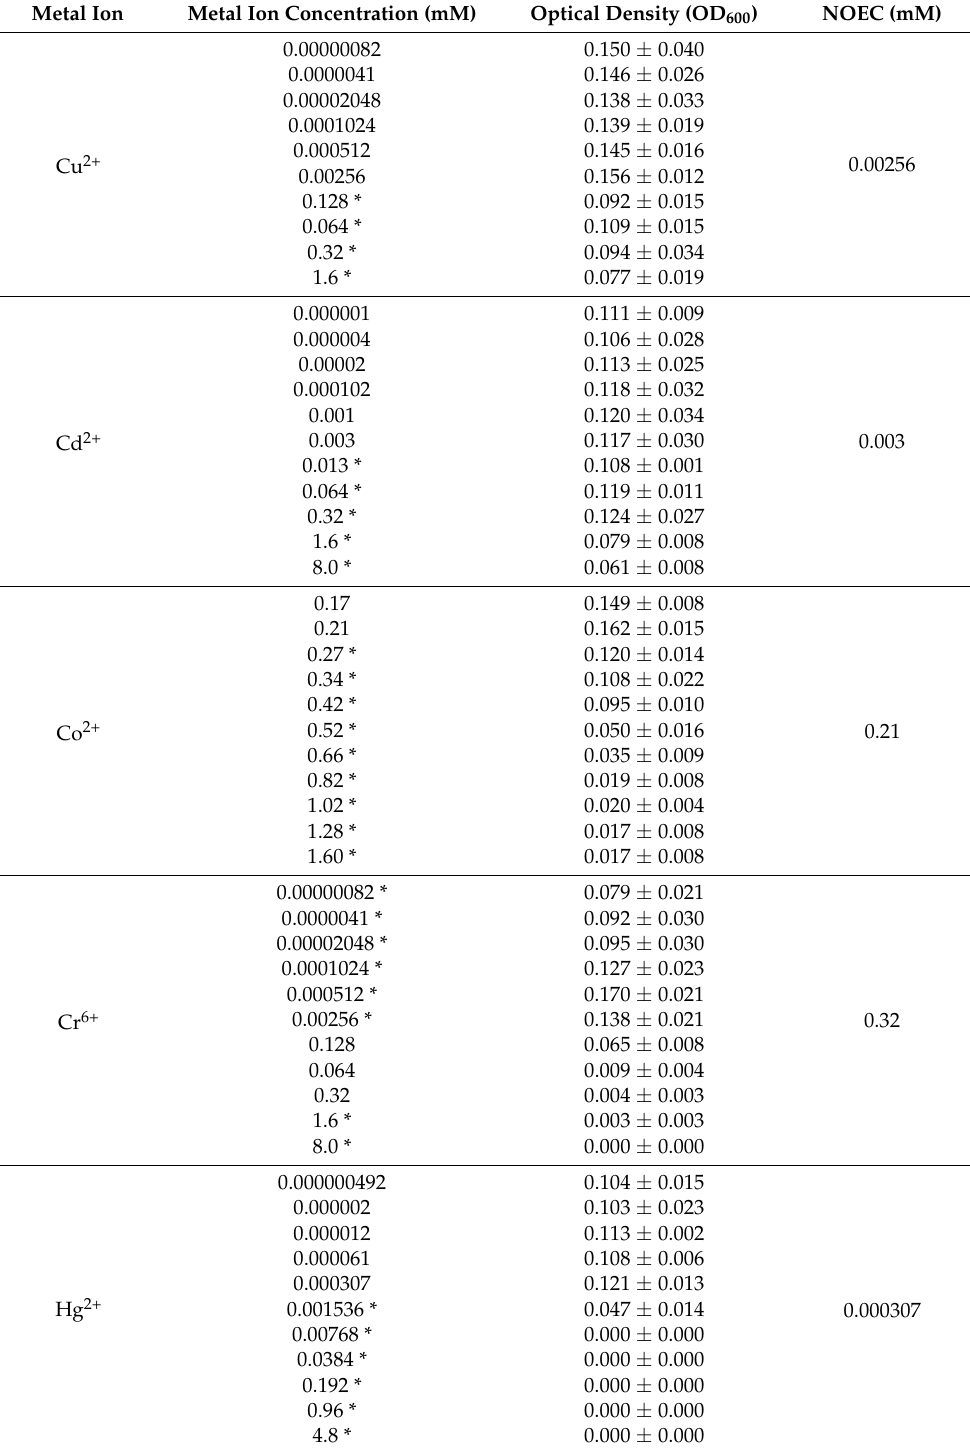
Table 1. Effect of metal ions on Bacillus thuringiensis B1(2015b)